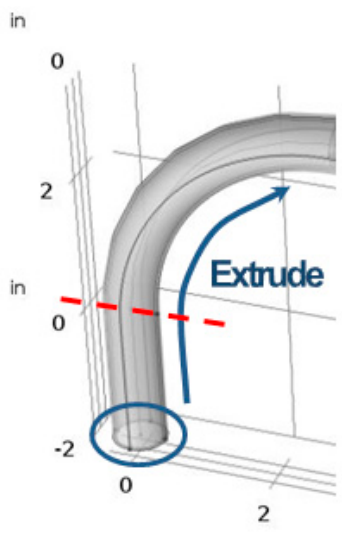
Figure 6. A simulation modeling concept of a U-bend tube.